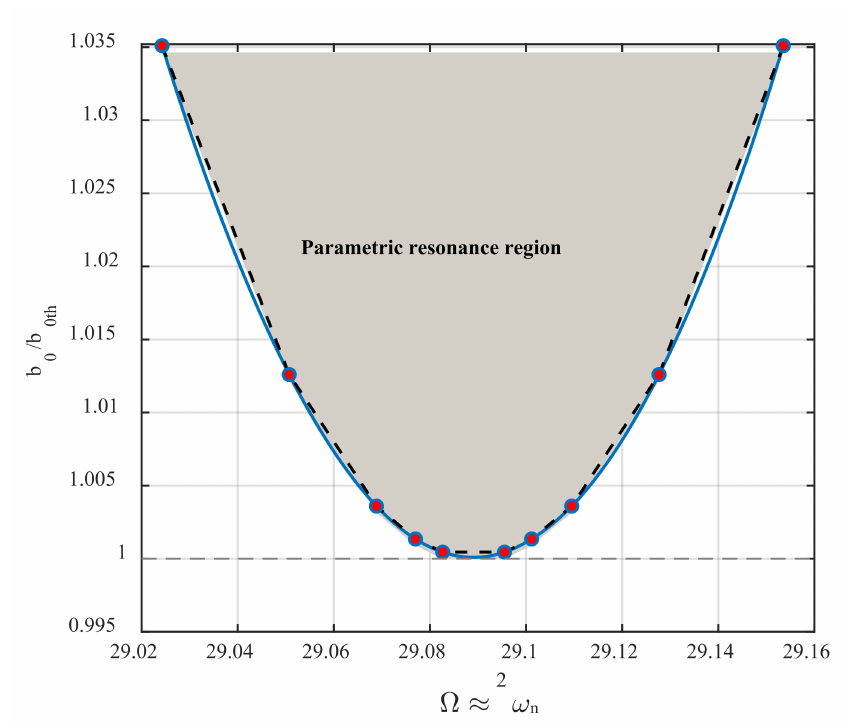
Figure 4. Instability tongue. The loci of both sub- and super-critical primary Hopf bifurcation points define the boundary of the parametric resonance region, where the threshold value for the base excitation amplitude is d th = 0.222